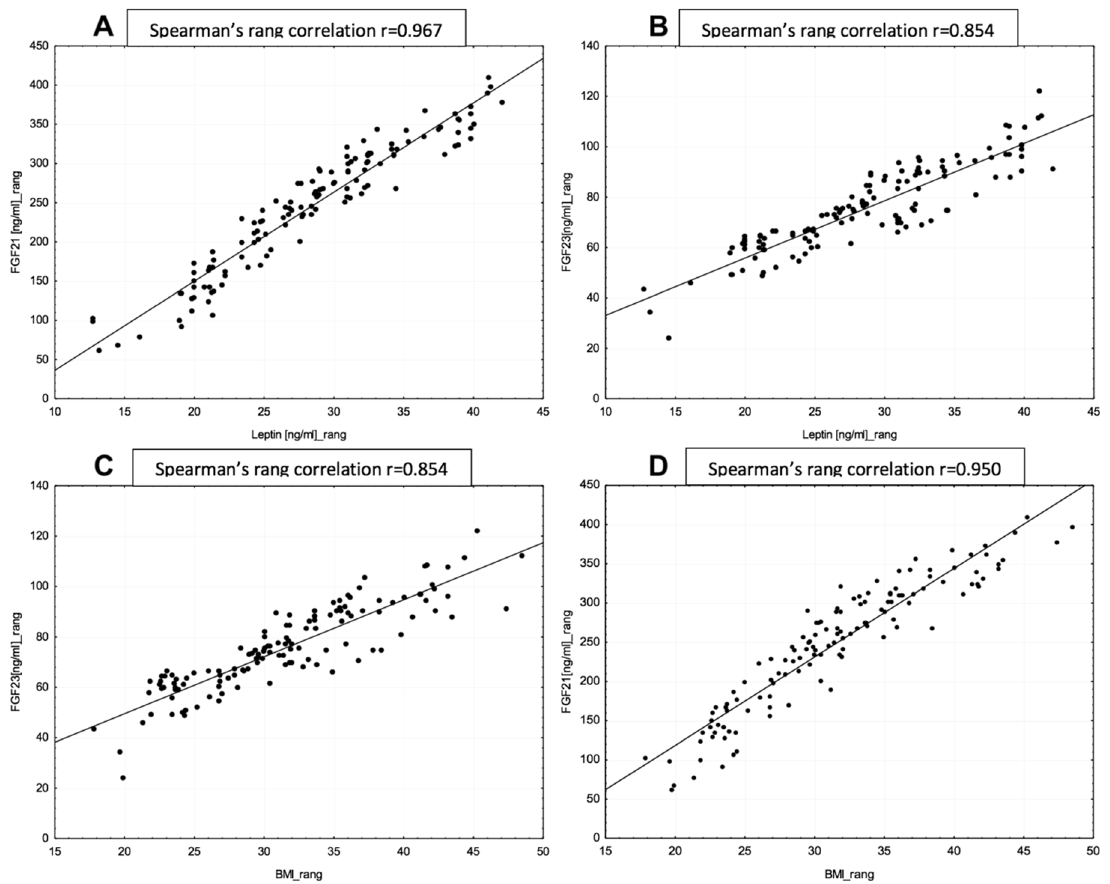
Figure 1. ( A ) Correlation between leptin and FGF 21 level. ( B ) Correlation between leptin and FGF 23 level. ( C ) Correlation between FGF23 level and BMI. ( D ) Correlation between FGF21 and BMI.